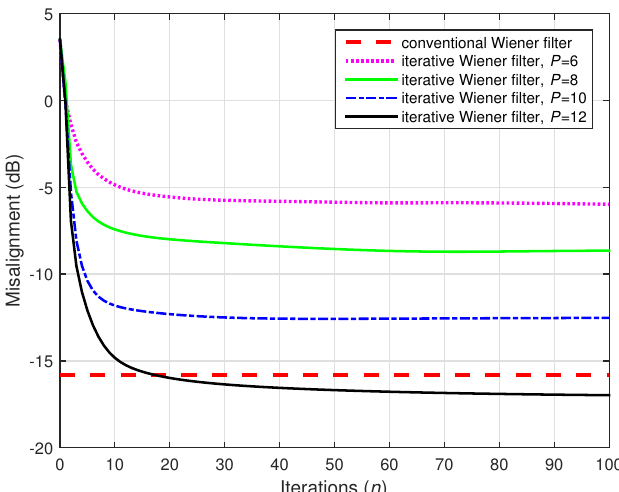
Figure 18. Performances of the conventional and iterative Wiener filters, using N = 10,000. The source signal (white Gaussian noise) was preprocessed with positive and negative half-wave rectifiers, using α = 0.5. The numbers of channels were M = 2 (stereophonic scenario), L = 1024, and SNR = 30